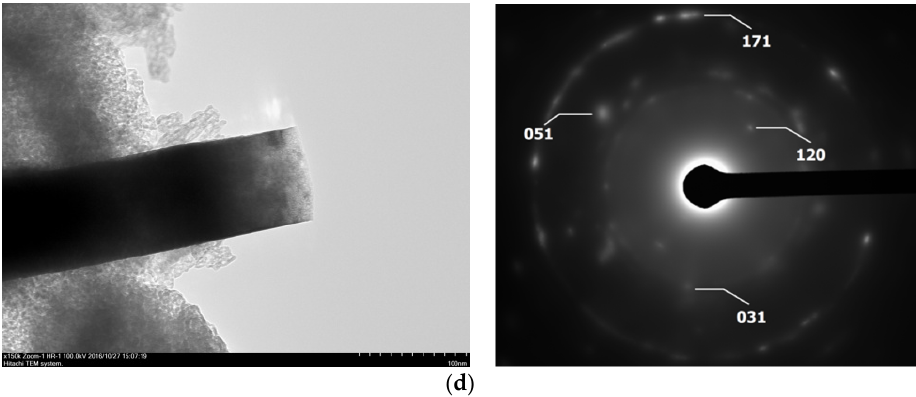
Figure 4. TEM images of ( a ) χ -Al 2 O 3 HTT product and the selected areas of surface for the electron diffraction of the individual structure ( b – d ). Sample composition: ( b ) C( χ -Al 2 O 3 ) = 63.0 wt %; ( c ) C(boehmite) = 31.0 wt %; ( d ) C(gibbsite) = 6.0 wt %.